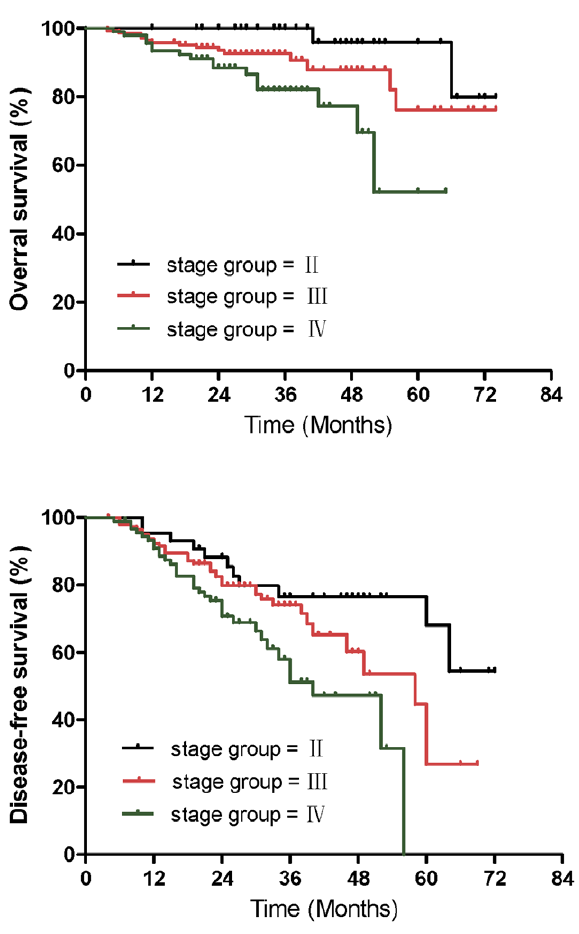
Figure 2. Kaplan-Meier estimates of Overral survival and disease-free survival for patients receiving with stage group